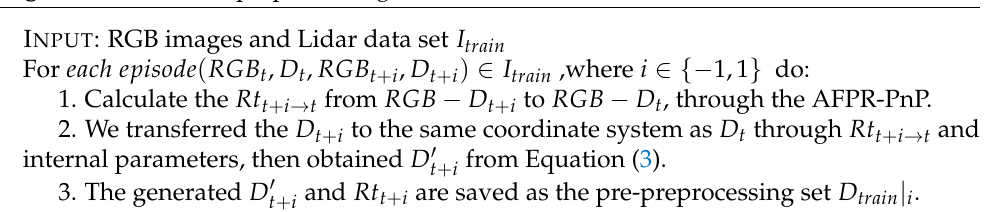
Algorithm 1 Data set preprocessing